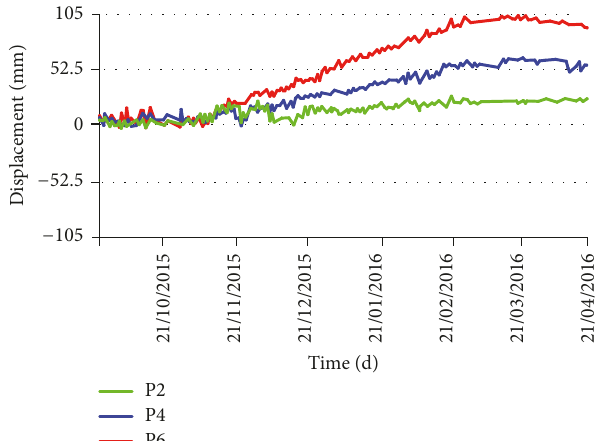
Figure 14: The displacement data of three different monitoring